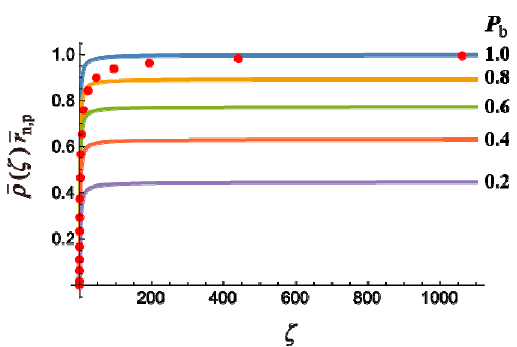
Figure 10. Expected branching density of the polymer whose reduced chain length is ζ (= r / r n,p ). The lines are for random branching with the given P b -values, and the circular symbols are for the conventional emulsion polymerization, C4.